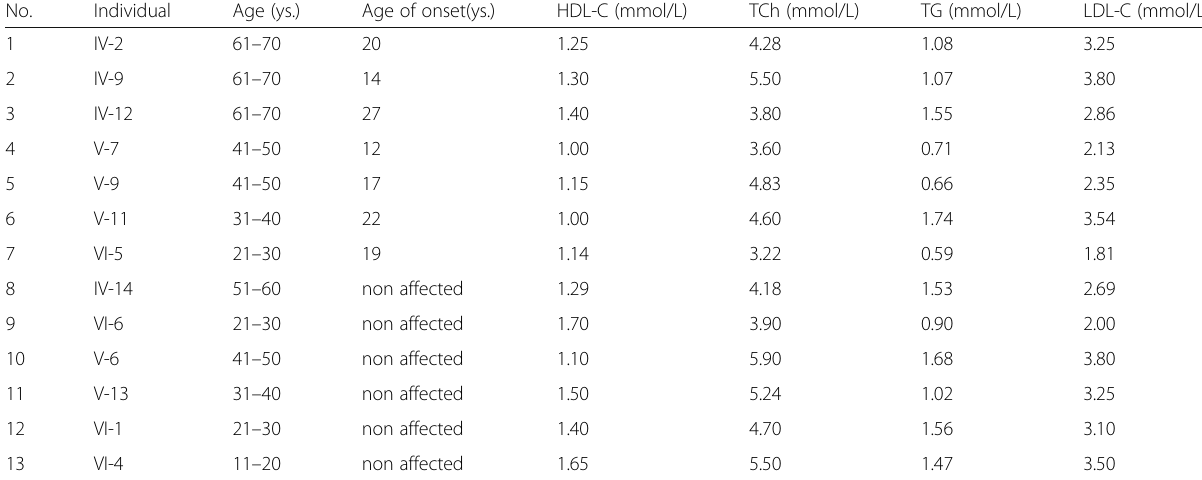
Table 1 The blood lipid level in members of this